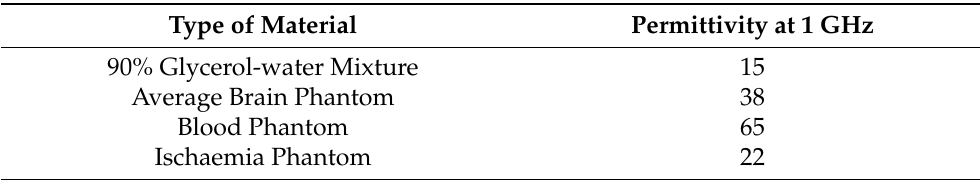
Table 1. Permittivity of glycerol solution, brain phantom, blood-mimicking target and ischaemia- mimicking target measured at 1 GHz.